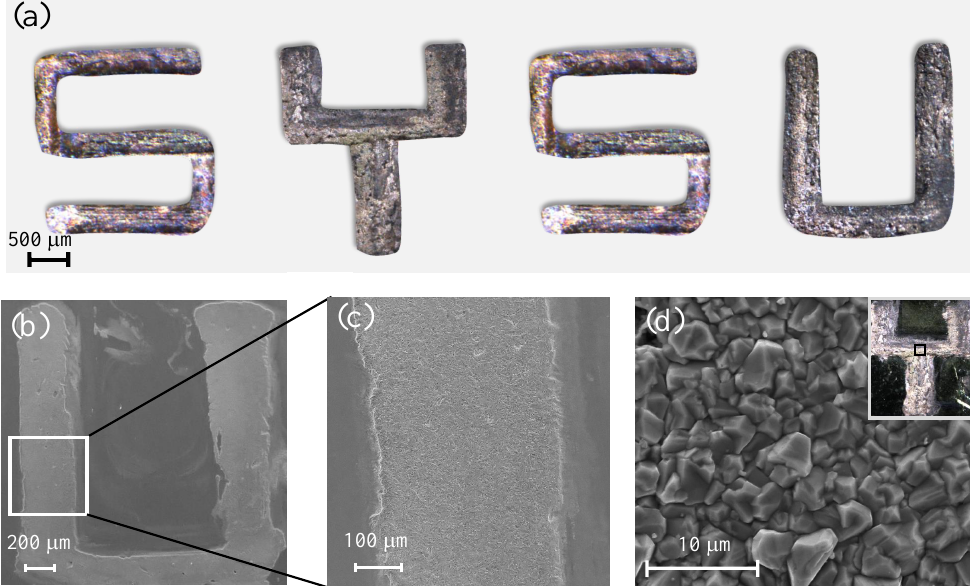
Figure 8. ( a ) Images of printed structures featuring the letters “SYSU.” Only the letters without the substrate are shown to make an uniform background. ( b ) A typical SEM image of the letter “U”; the zoomed-in view of the white boxed area is shown in ( c ). ( d ) SEM image of the white boxed area in letter